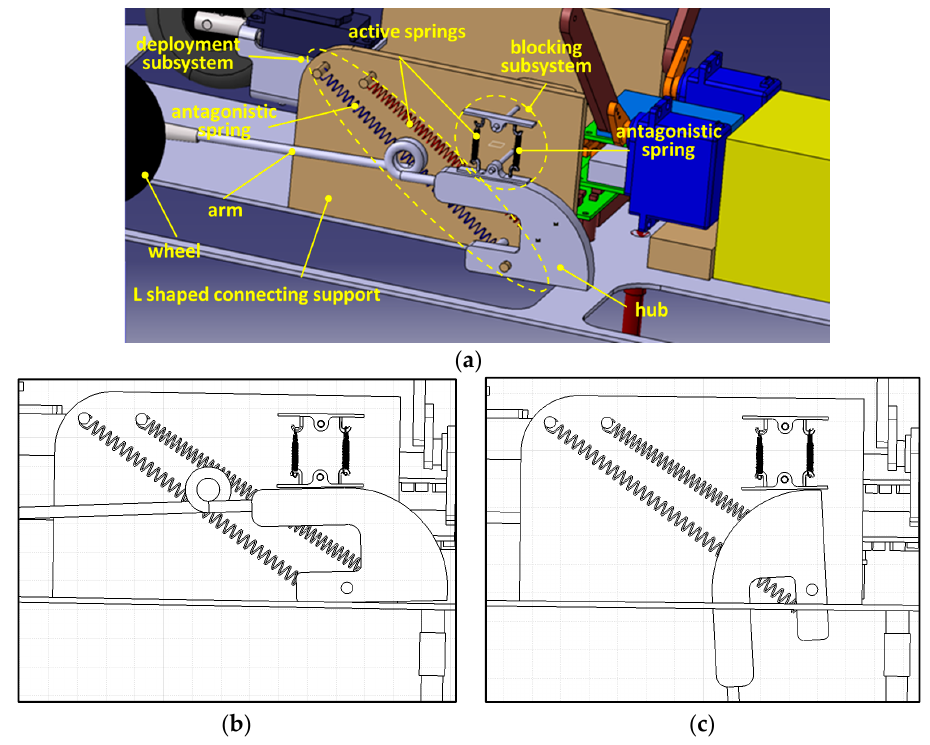
Figure 10. Computer-aided design details of the deployment and blocking subsystems ( a ); attitude in retracted ( b ) and deployed configuration ( c ). Table 3. Characteristics of deployment and blocking subsystems.